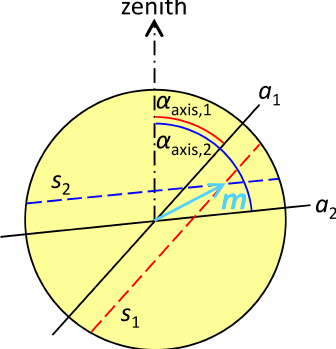
Figure 1. Schematics of the mispointing determination strategy. So- lar line shifts are measured at times t 1 and t 2 with corresponding solar axis orientations α axis,1 and α axis,2 . The mispointing vector m is defined by the intersection of the lines s 1 and s 2 parallel to the so- lar rotation axes a 1 and a 2 , respectively. Differential solar rotation is neglected in this